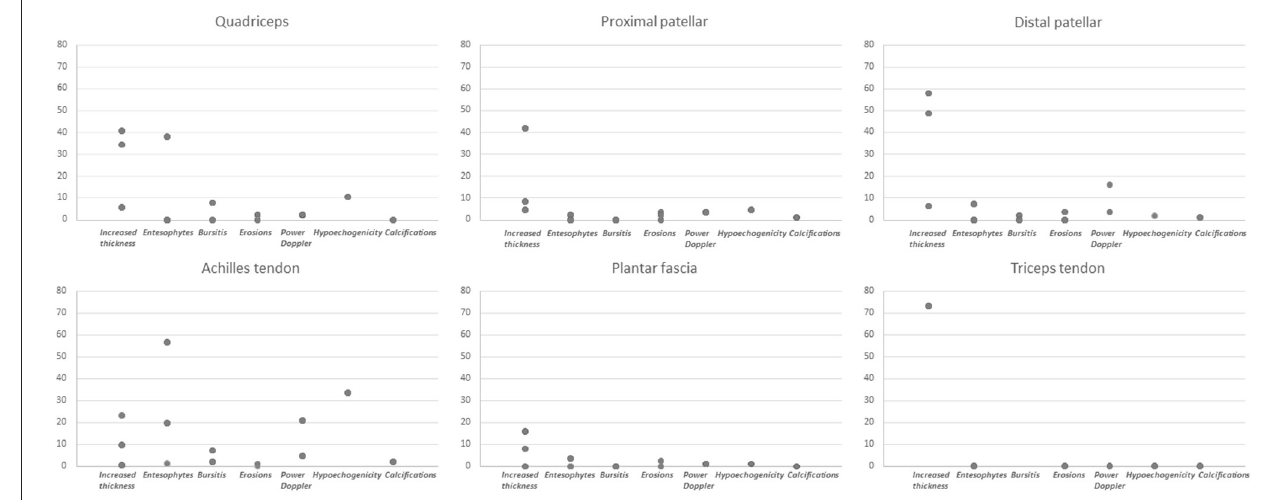
FIGURE 2 | Summary of frequencies for each lesion at entheseal